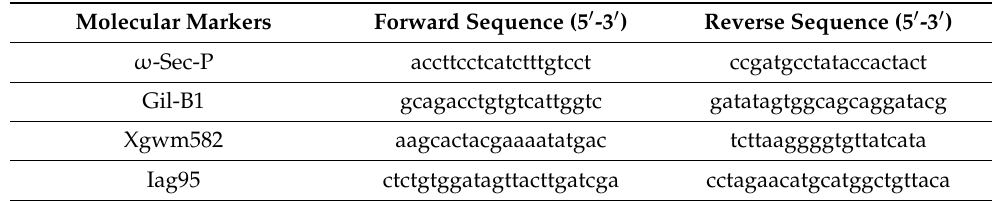
Table 4. The sequences of the molecular markers used in this study. Molecular